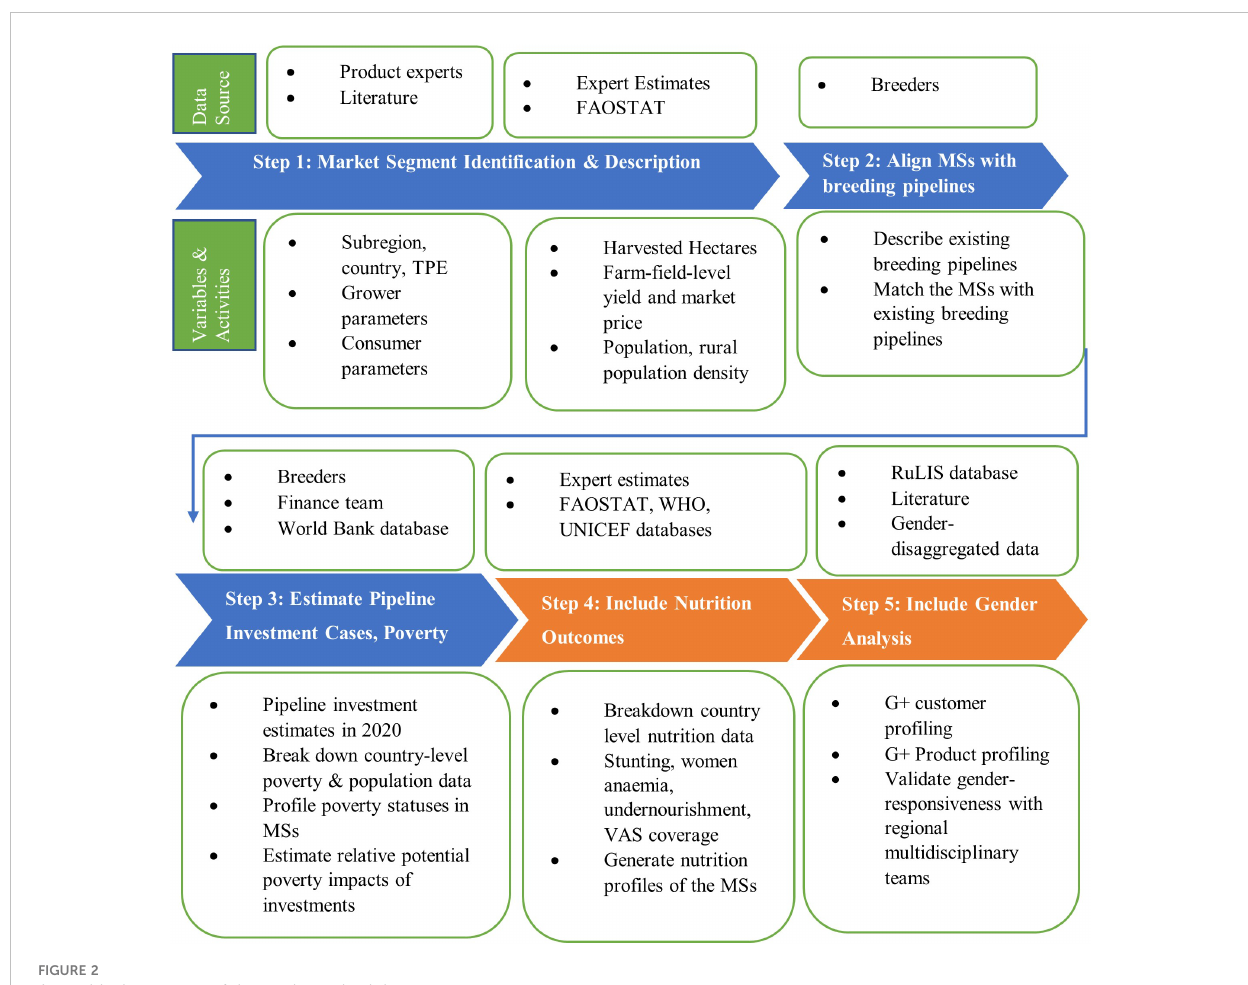
FIGURE 2 A graphical summary of the study